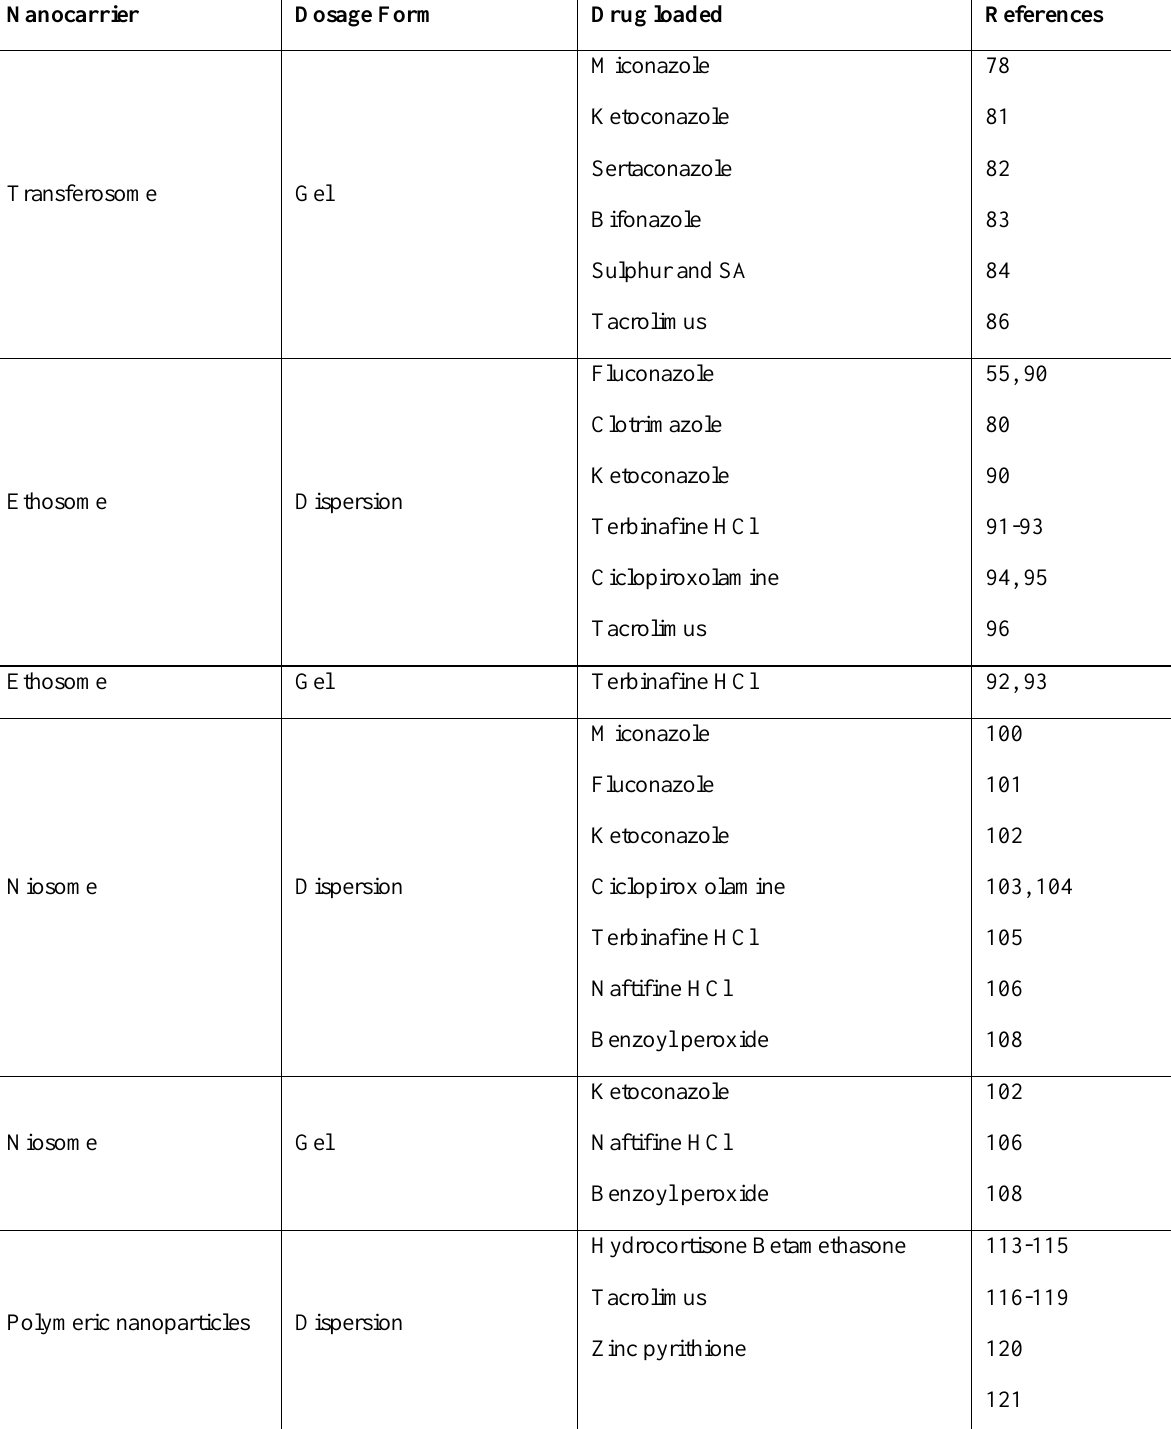
Continue Table 2. Summary of the most common nanocarriers for skin delivery of drugs used in